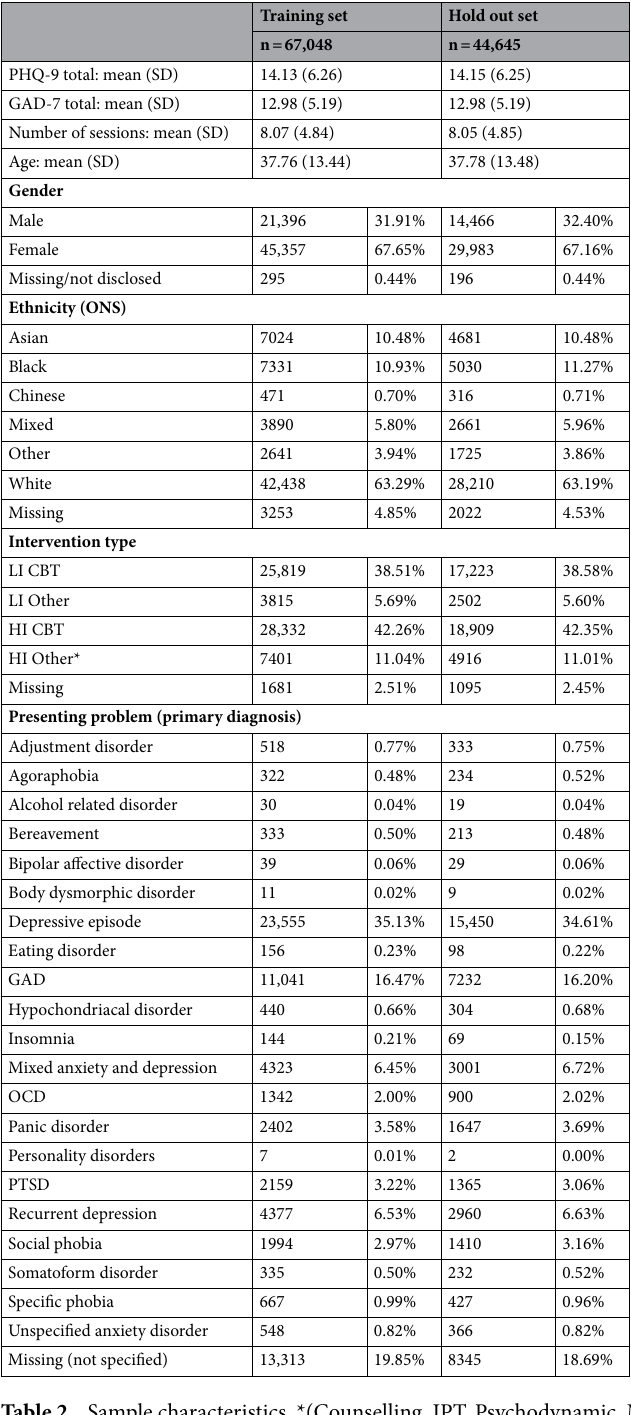
Table 2. Sample characteristics. *(Counselling, IPT, Psychodynamic, MBCT,